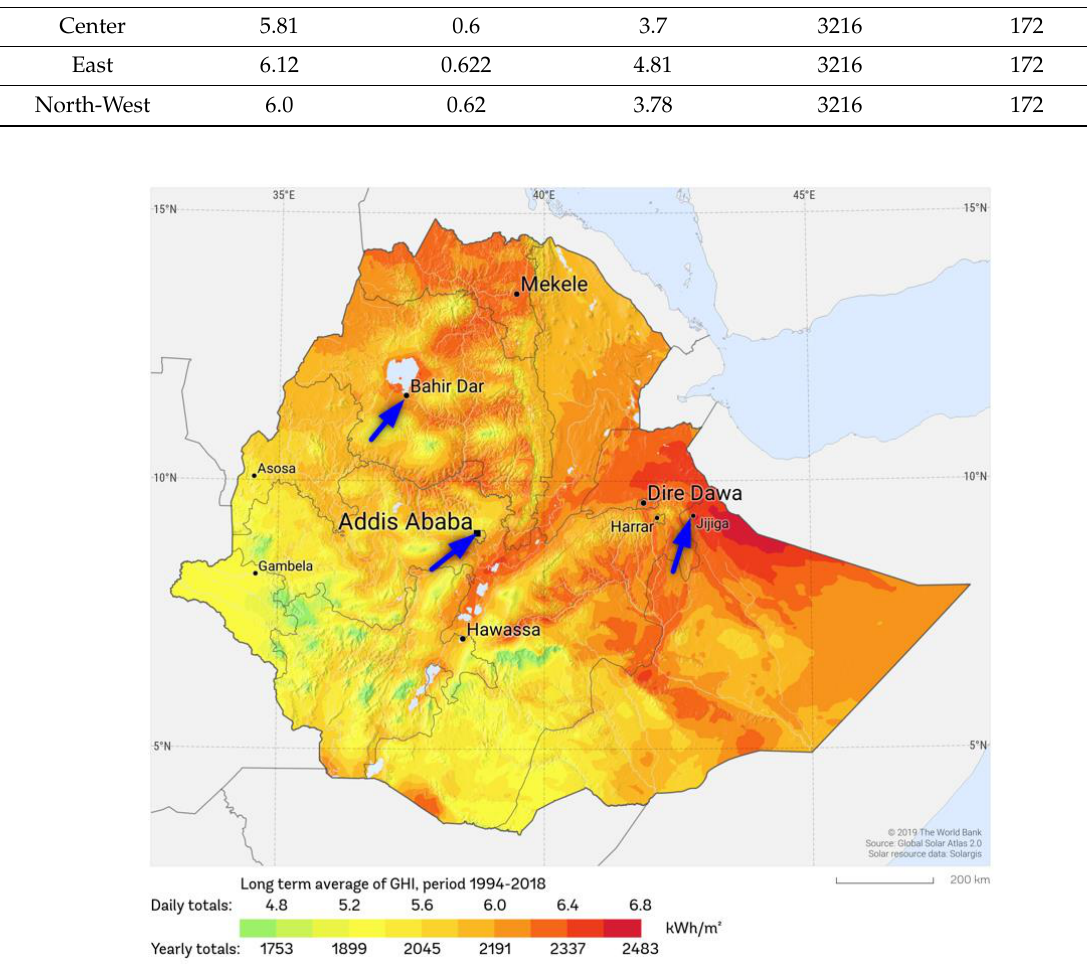
Figure 1. Study locations and global horizontal irradiation in Ethiopia [46].